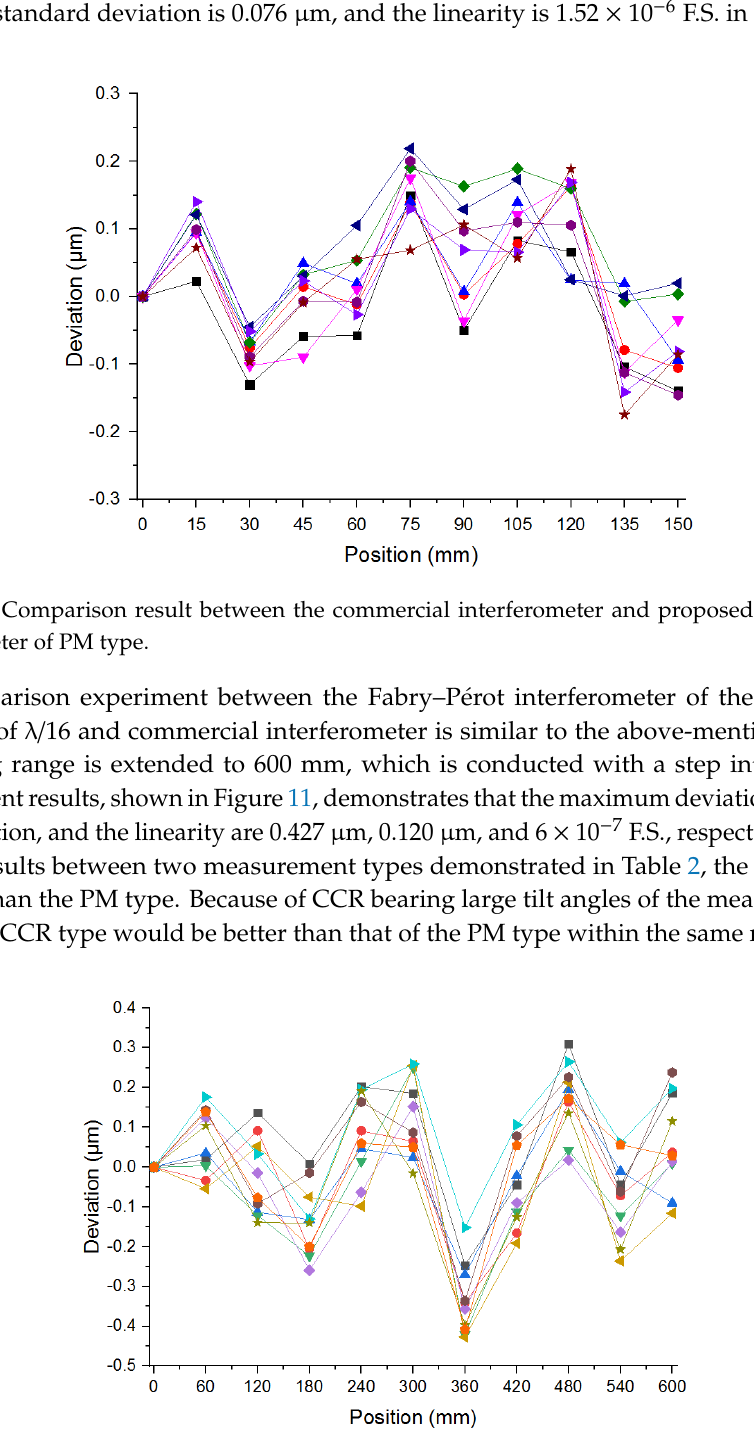
Figure 11. The comparison result between the commercial interferometer and proposed Fabry–Pérot interferometer of CCR type.